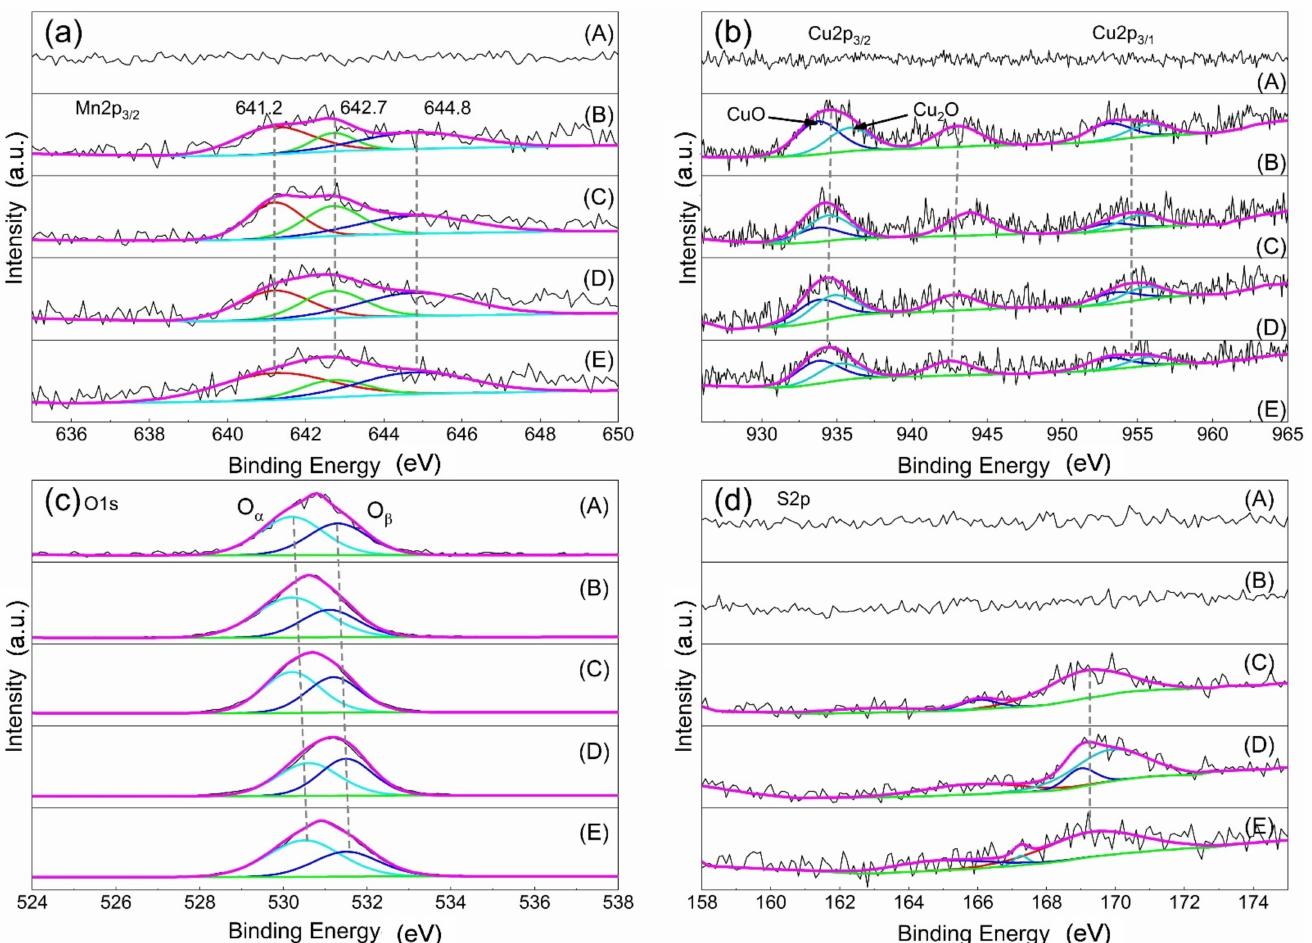
Figure 8. XPS spectrum of ( a ) Mn2p, ( b ) Cu2p, ( c ) O1s, ( d ) S2p. A, AC; B, fresh catalyst; C, sulfur poisoning; D, thermal regeneration; E, rinsing